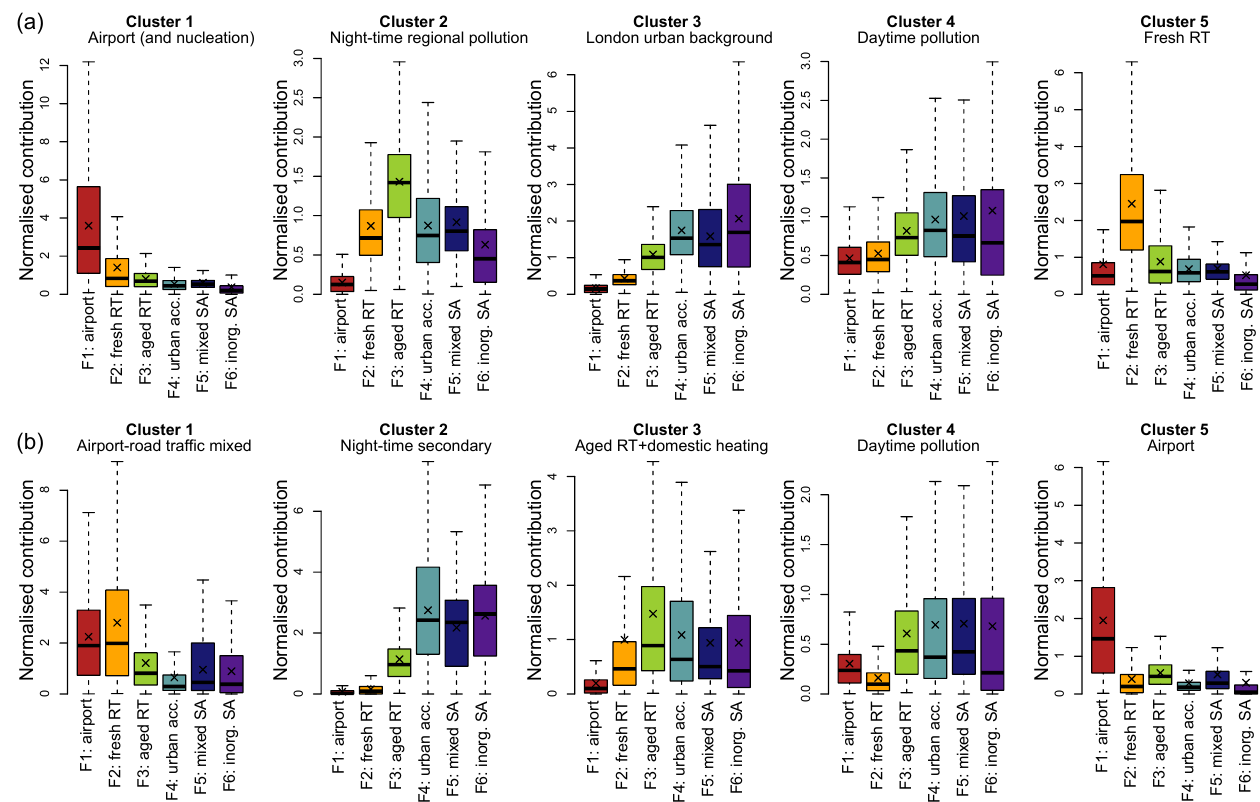
Figure 8. Comparison of k means and PMF for the warm (a) and cold (b) seasons. Boxplot statistics: lines – medians; crosses – arithmetic means; boxes – 25th–75th percentile ranges; whiskers – ± 1 . 5 × interquartile ranges.